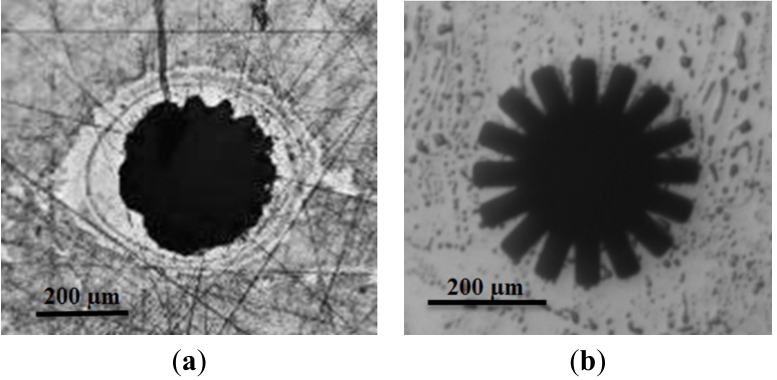
Figure 5. Top view on nozzle outlet fabricated with old process P0 described in [15] ( a ), and top view on nozzle outlet fabricated with enhanced process P1 described below ( b ).